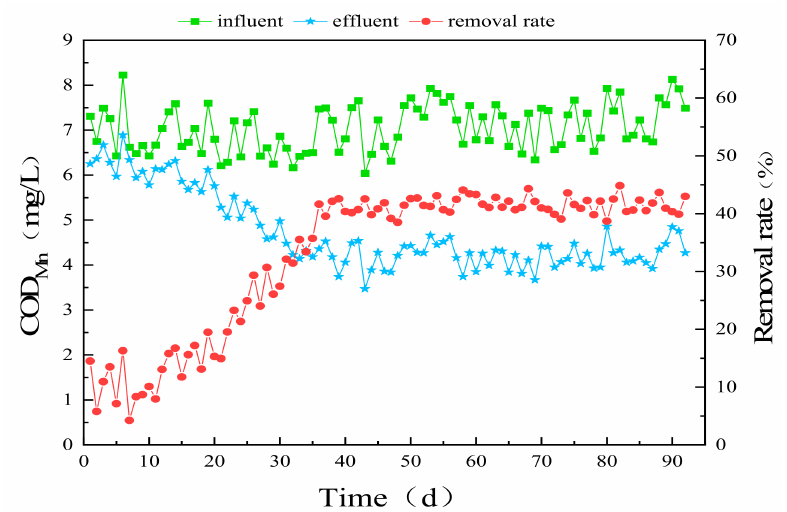
Figure 2. COD Mn use reduction in aeration biofilter